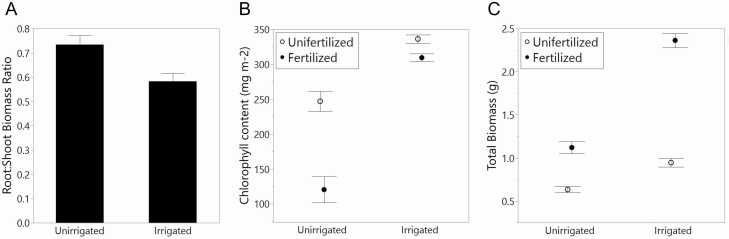
(A) The effect (mean ± SE) of irrigation treatment on root:shoot ratio (P = 0.0008). The interactive effect (mean ± SE) of irrigation and fertilization on (B) chlorophyll content (P < 0.0001) and (C) total biomass (P < 0.0001).